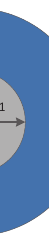
Figure 3. Demonstration of the two-layer structure of the optical fiber with a cladding diameter of 2 r 1 = 125 µ m and a jacket diameter of 2 r 2 .